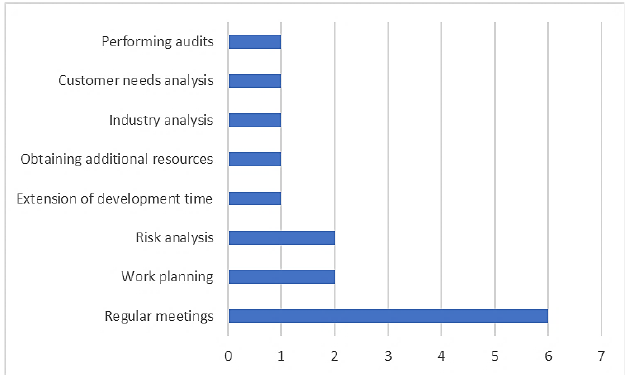
Fig. 9. The most popular risk mitigation activities in the surveyed